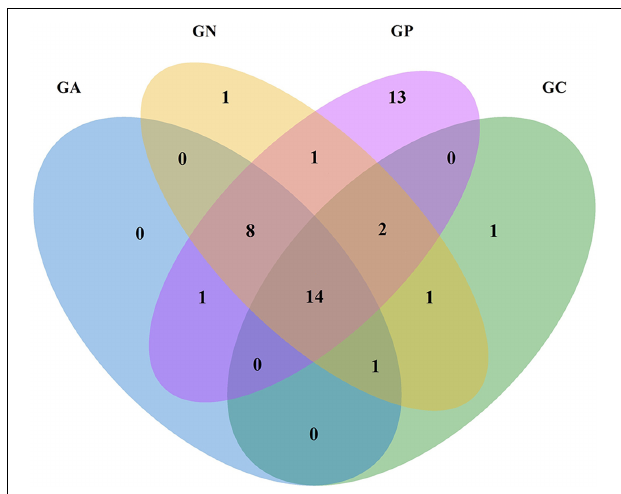
FIGURE 2 | Venn diagram of four groups at the order level according to the classification of the bacterial 16S rRNA V3 and V4 regions. GC, control group; GP, phage-therapy group; GN, negative control group; GA, antibiotic-therapy group.